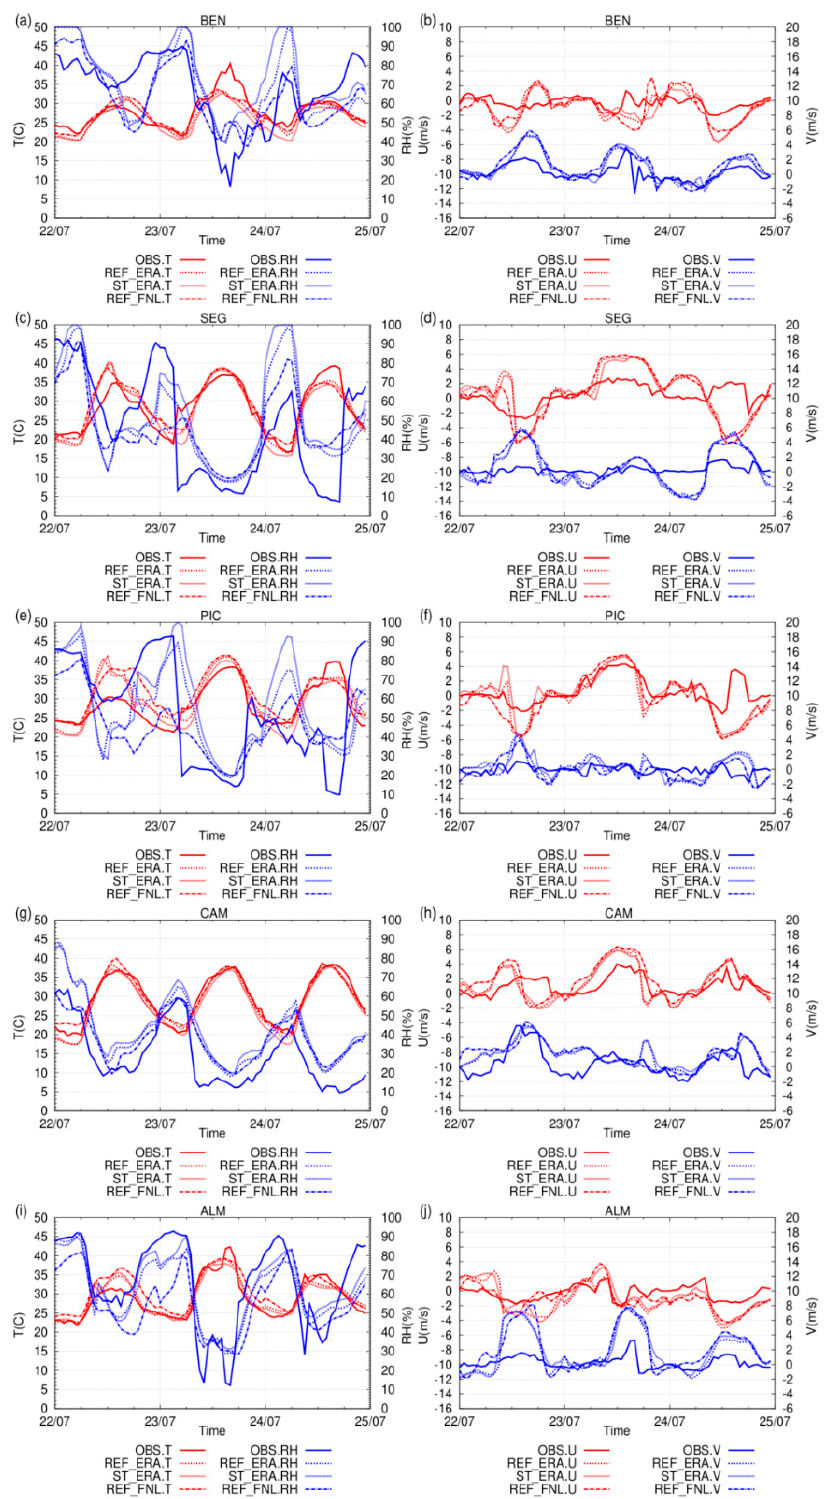
Figure 10. ( a – j ) Comparison of the simulated 2-m temperature (°C) and relative humidity (%), considering the REF_ERA, ST_ERA and REF_FNL simulations, for the whole intense-heat weather event, and observations at different representative weather station ( left ): BEN ( a ); SEG ( c ); PIC ( e ); CAM ( g ); ALM ( i ). The same for the wind field components (m/s; right ): BEN ( b ); SEG ( d ); PIC ( f ); CAM ( h ); ALM ( j ).